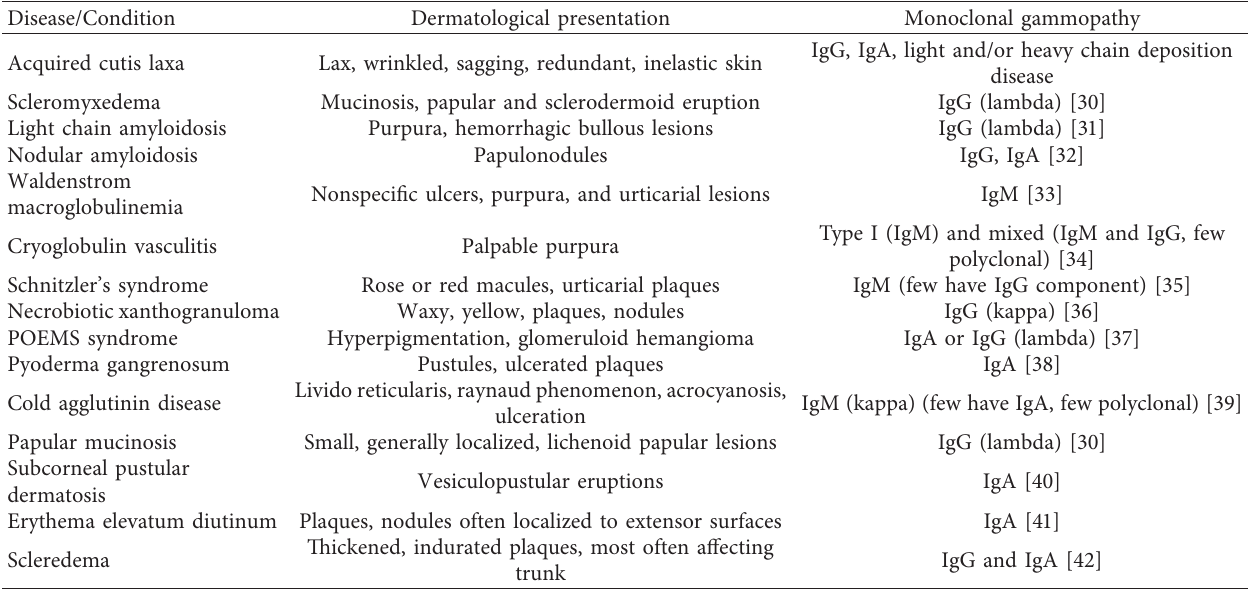
Table 2: Summary of monoclonal gammopathies of dermatological